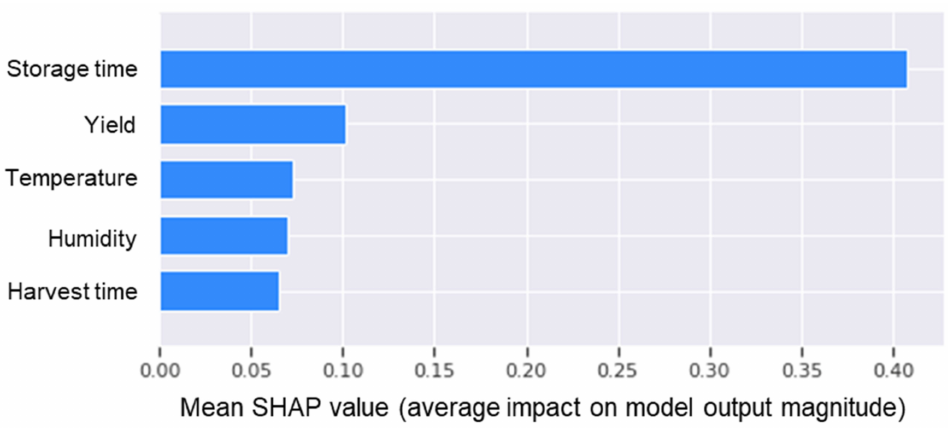
Figure 5. Feature importance of various preharvest and postharvest factors on the quality of ‘Valencia’ oranges. The presented data are SHAP